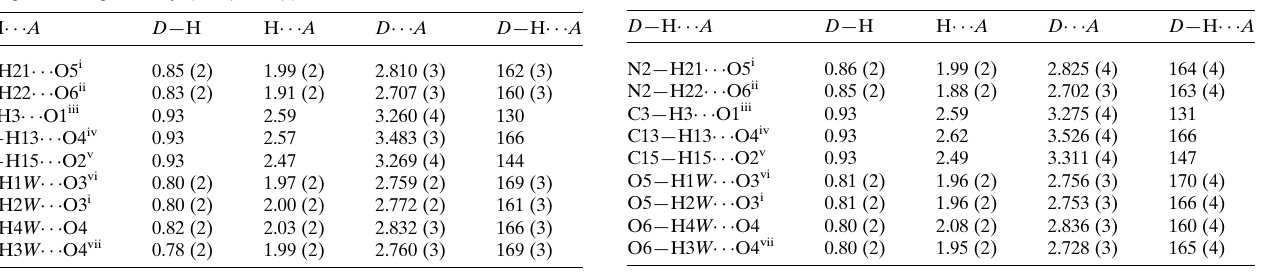
Table 2 Hydrogen-bond geometry (A˚ , (cid:5) ) for (II).